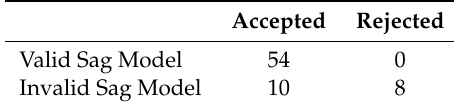
Table 4. Sag model rejection performance on the extended Gilberthorpes dataset.